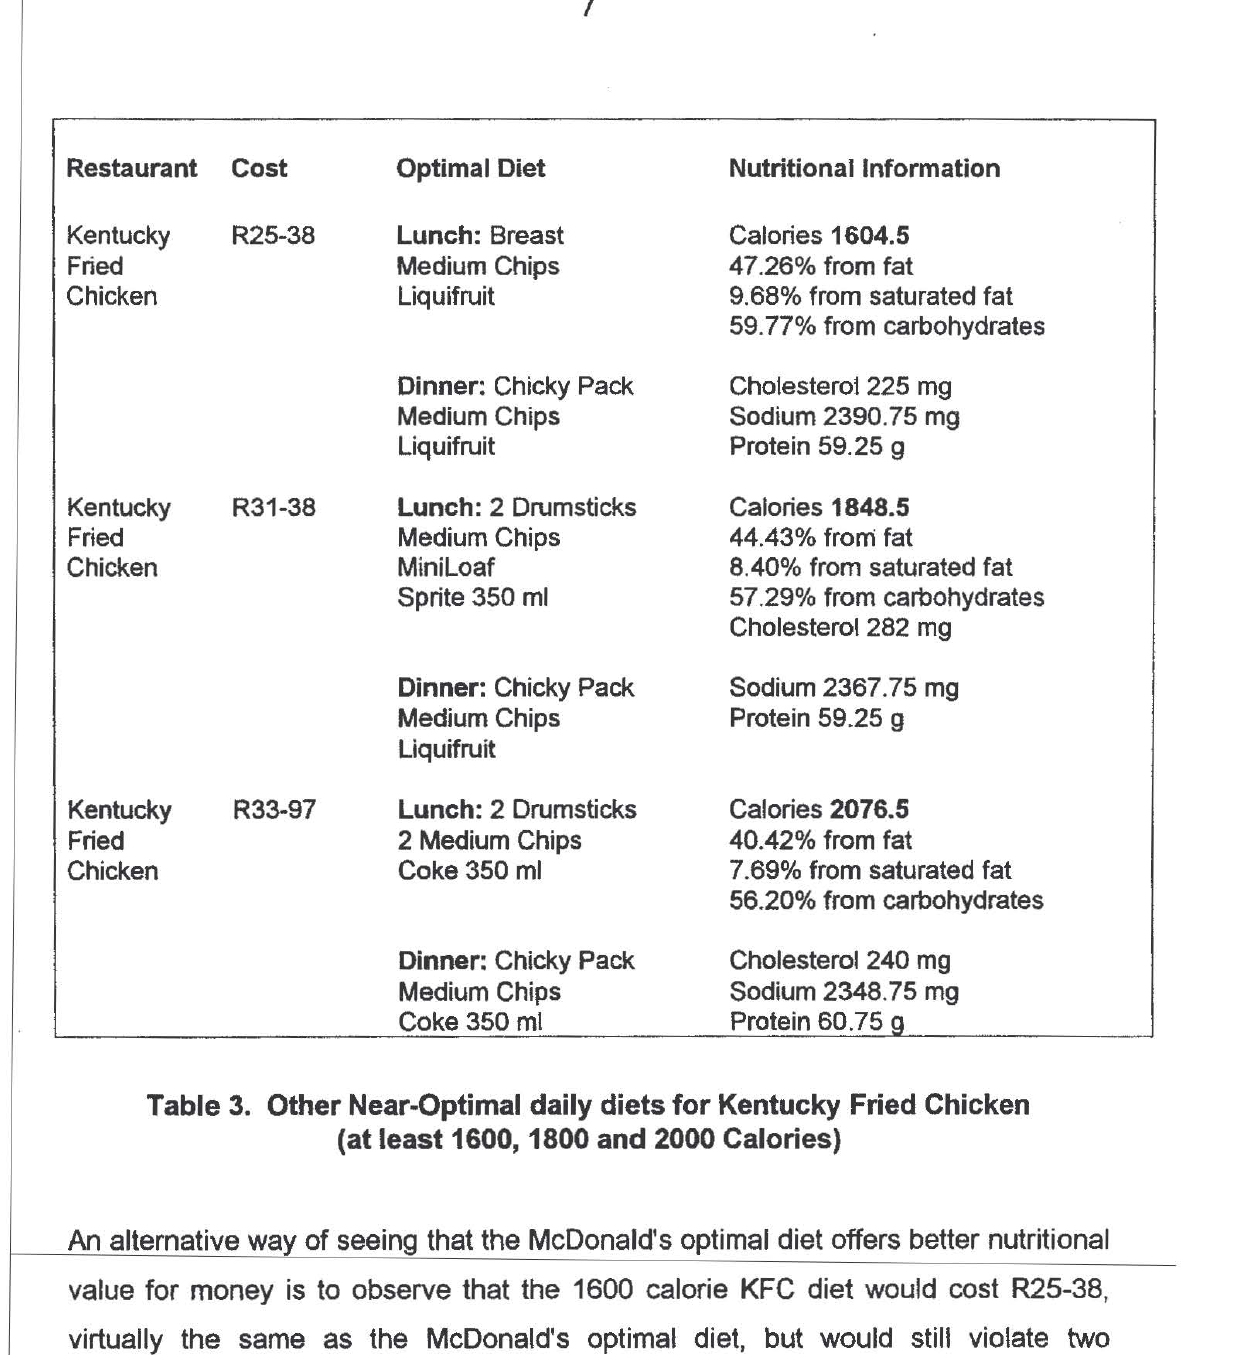
Table 3. Other Near-Optimal daily diets for Kentucky Fried Chicken (at least 1600, 1800 and 2000